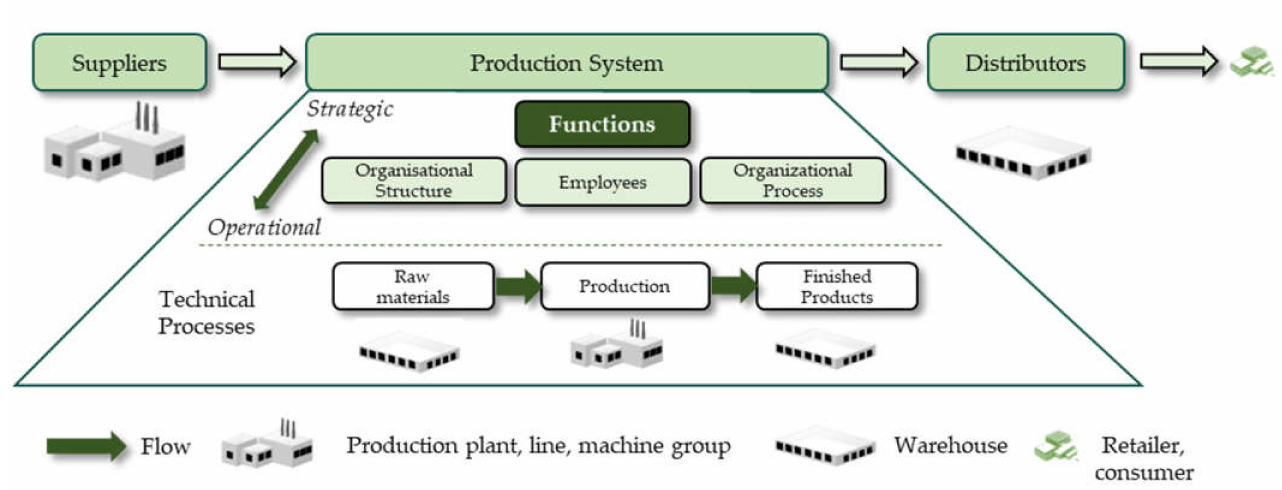
Figure 8. Structure of the simulation case study (the authors’ own